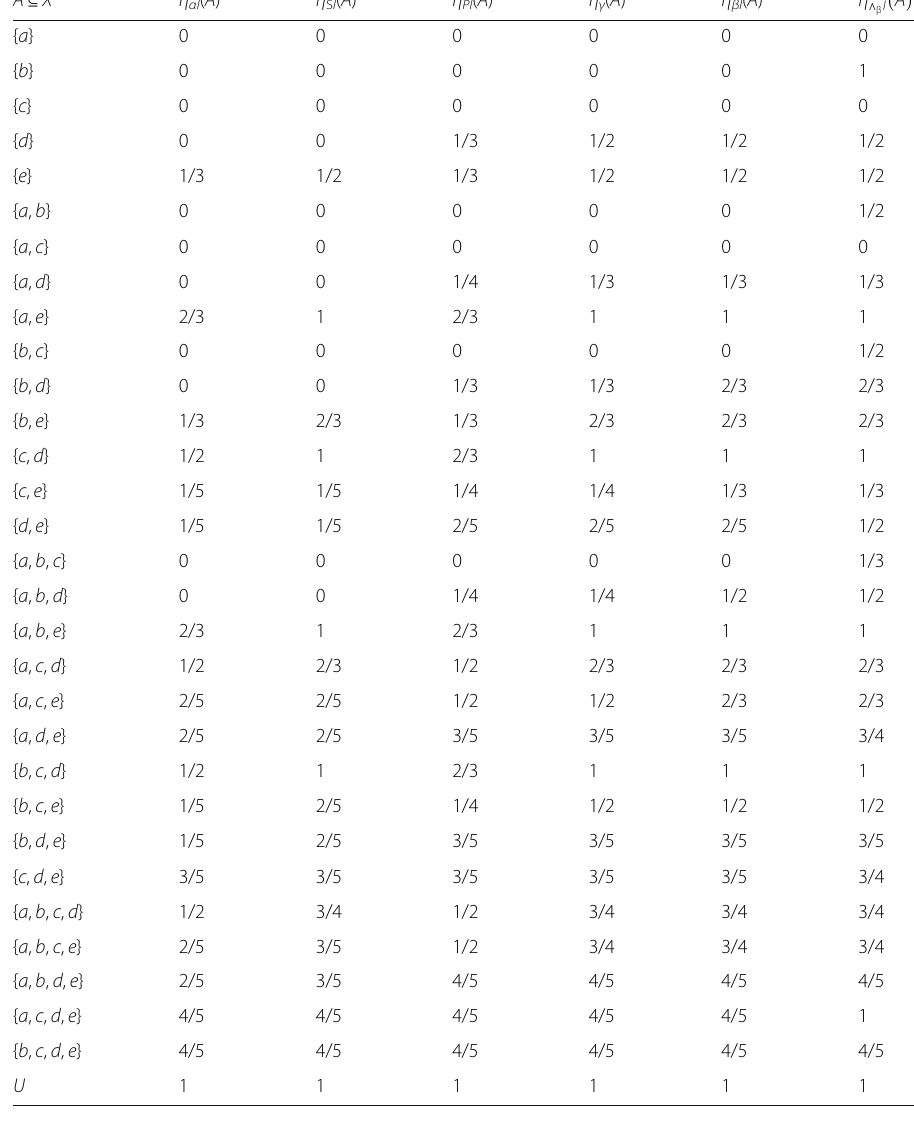
Table 1 jI − accuracy measure for any nonempty subset A of